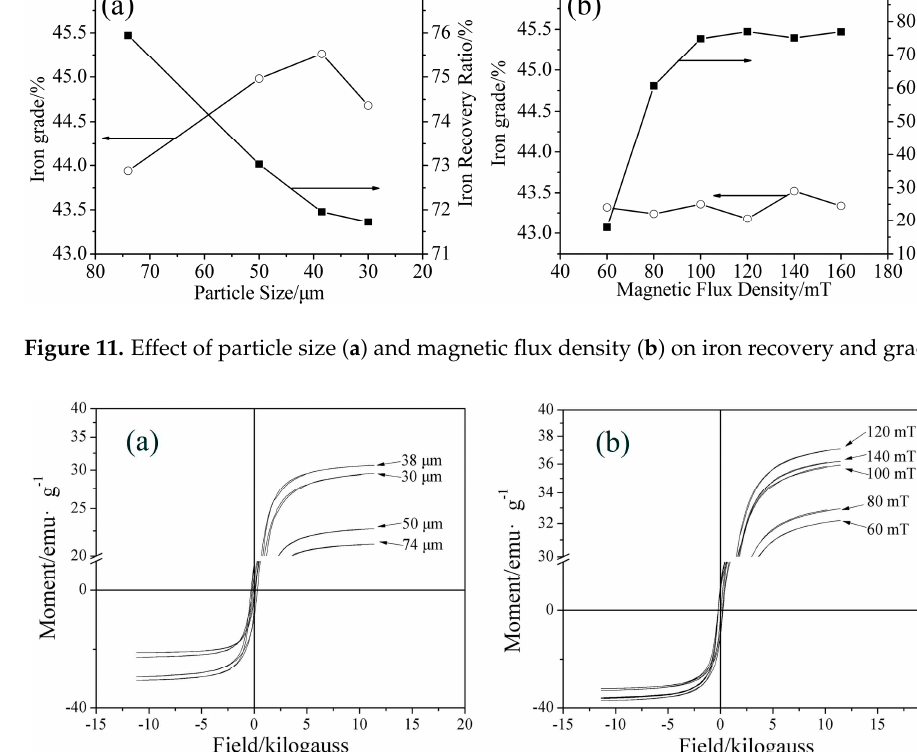
Figure 12. Effect of particle size ( a ) and magnetic flux density ( b ) on saturation magnetization.